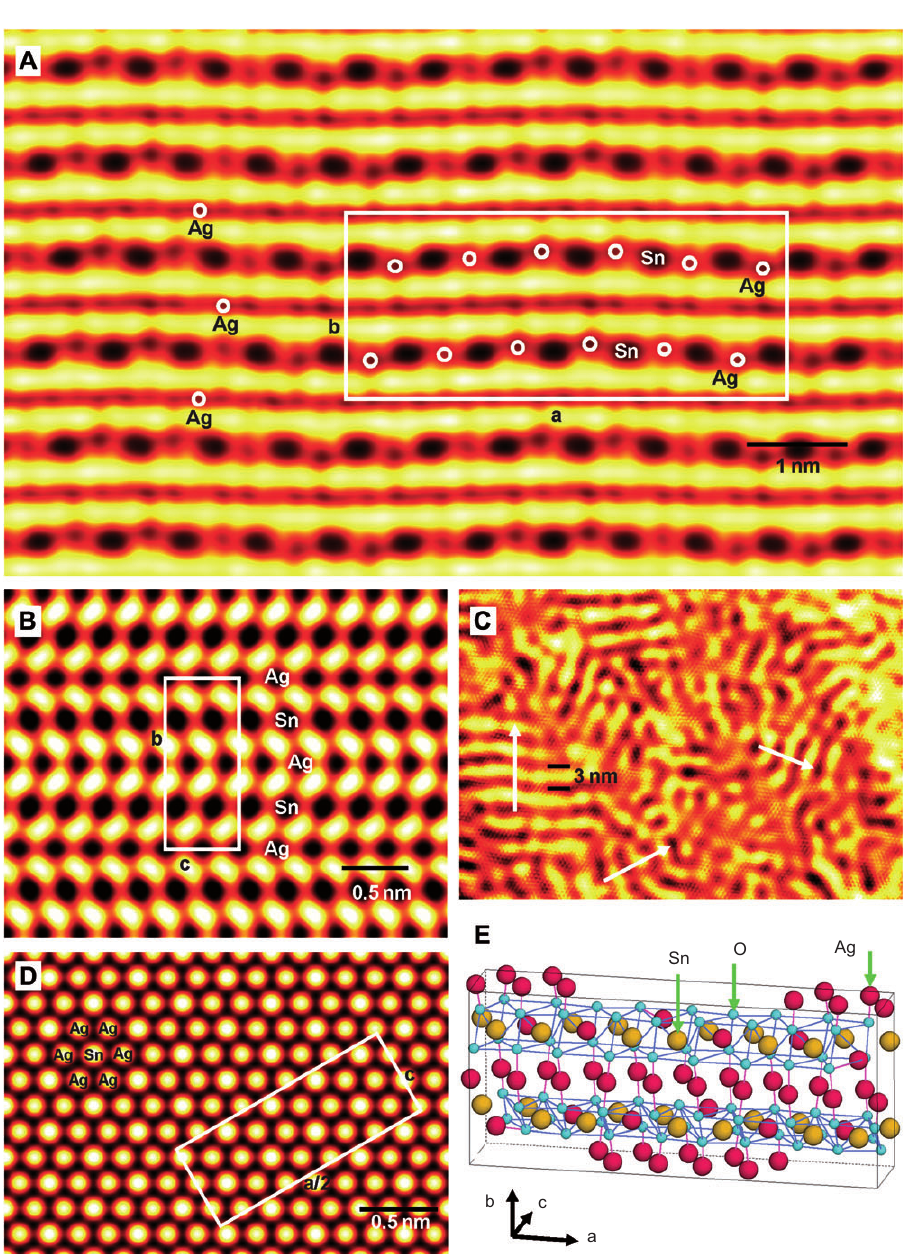
Figure 4 HREM images of Ag lated